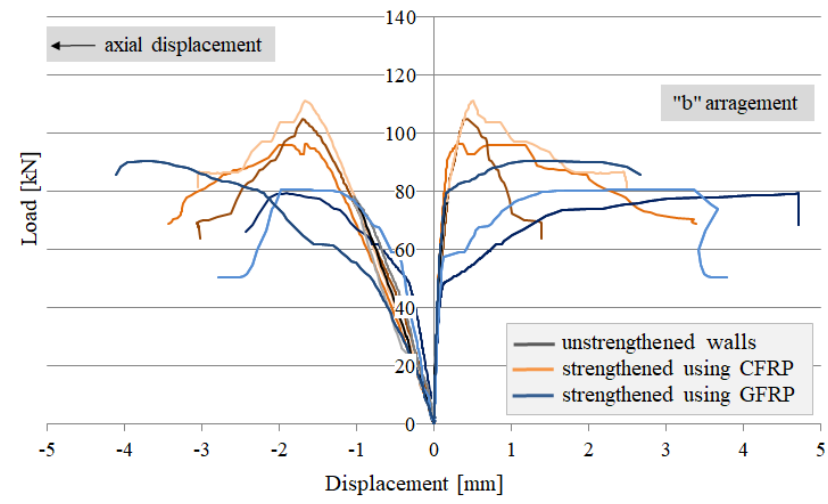
Figure 8. Horizontal and vertical displacement of the tested walls—configuration ‘b’.